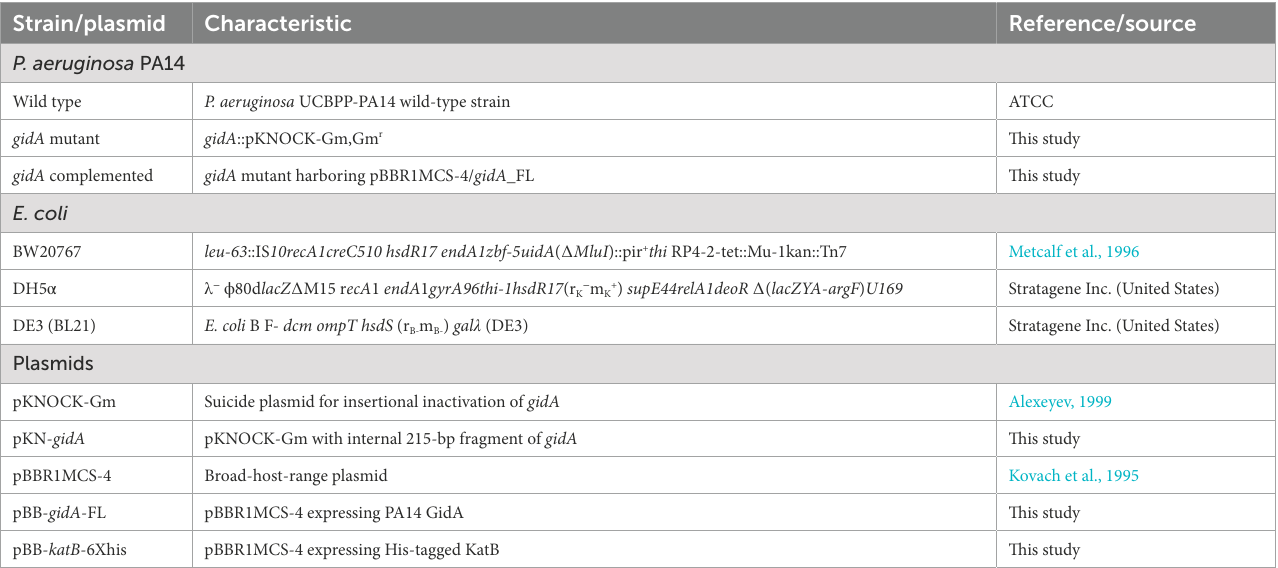
TABLE 1 Strains and plasmids used in this